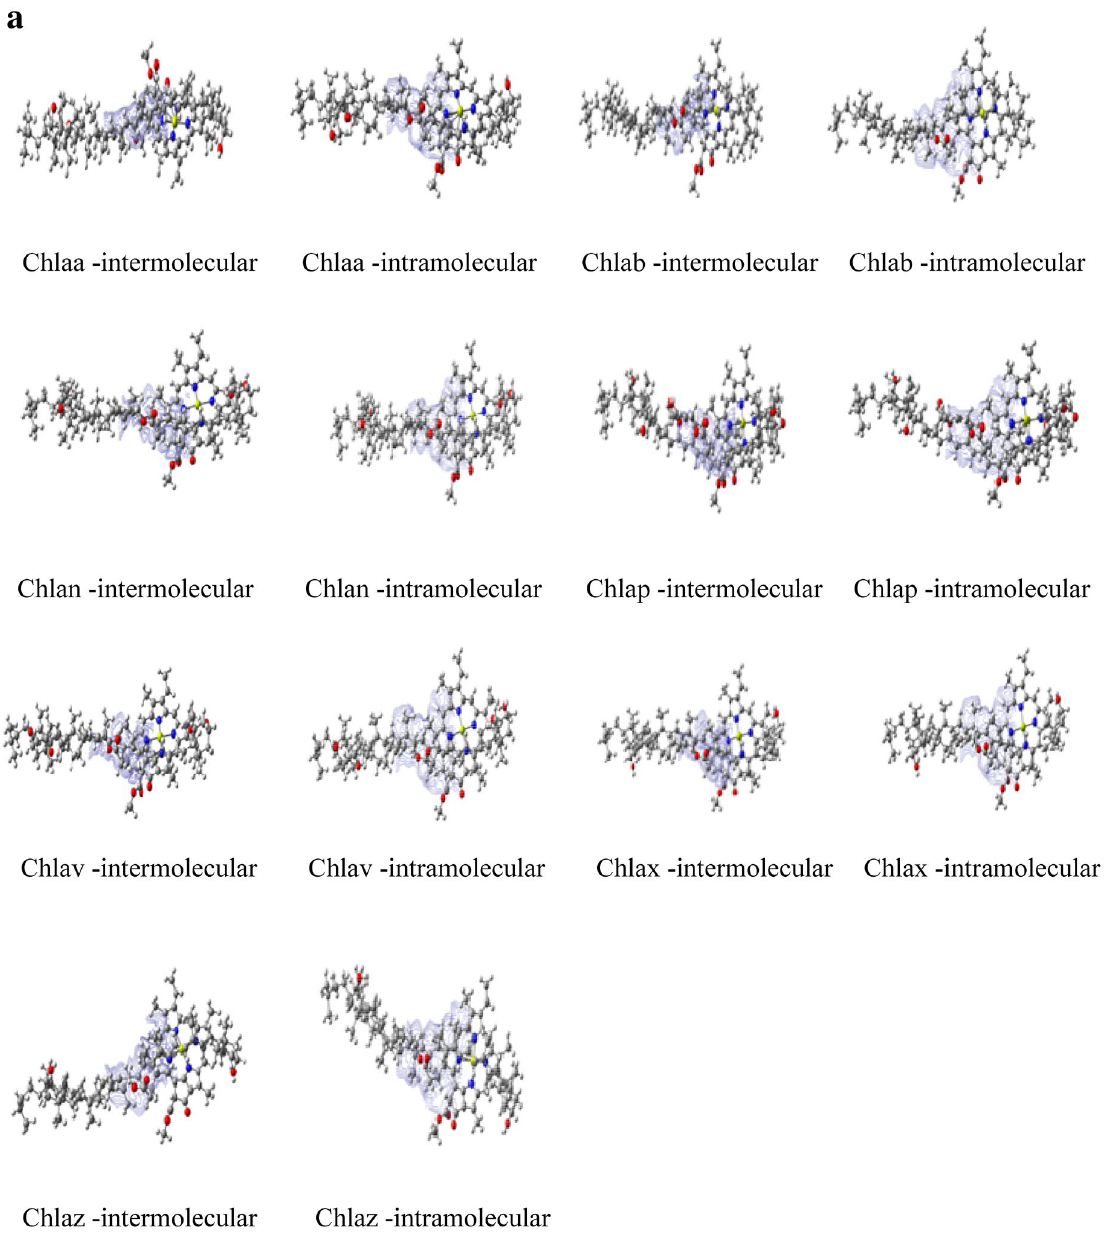
Figure 3. ( a ) Intermolecular and Intramolecular interactions of Chl a -carotenoid complexes by IGMPLOT. The visualized images have been taken from Gaussview programme. ( b ) Intermolecular and Intramolecular interactions of Chlb-carotenoid complexes by IGMPLOT. The visualized images have been taken from Gaussview